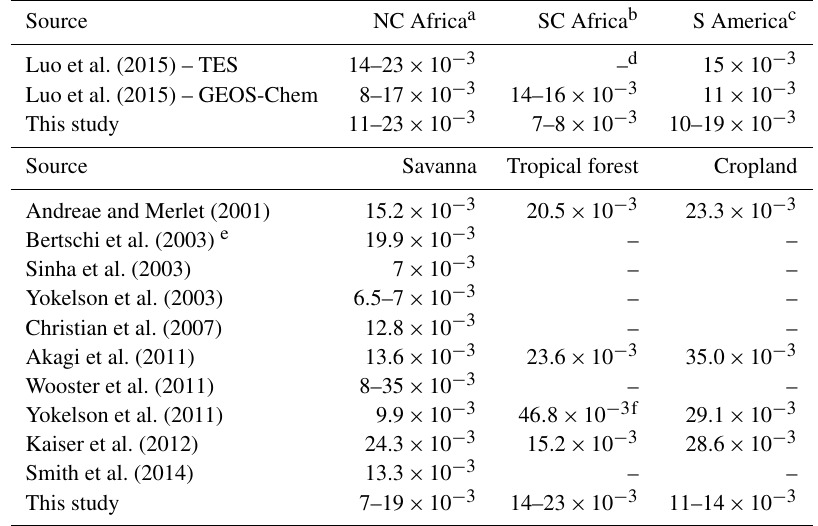
ratios calculated in this study are given as